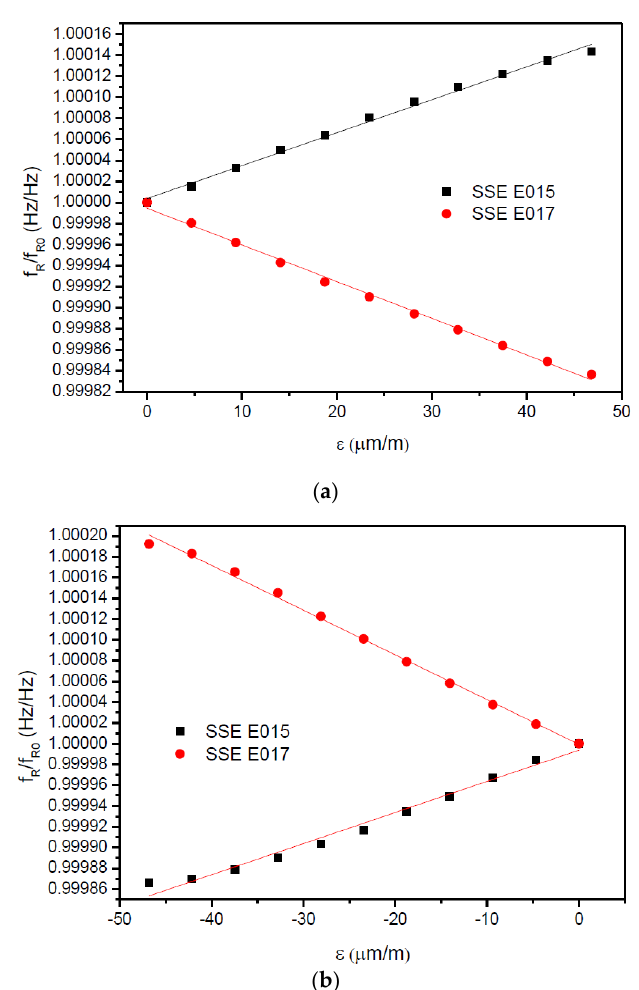
Figure 9. Relative resonance frequency of gages SSE E015 and SSE E017 for different values of strain applied in ( a ) downward direction and ( b ) upward direction. Values were measured at 25 °C.